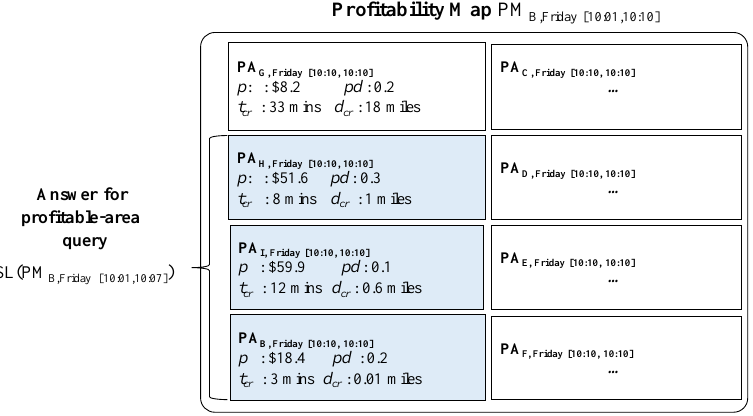
Figure 15. Profitable-area query data